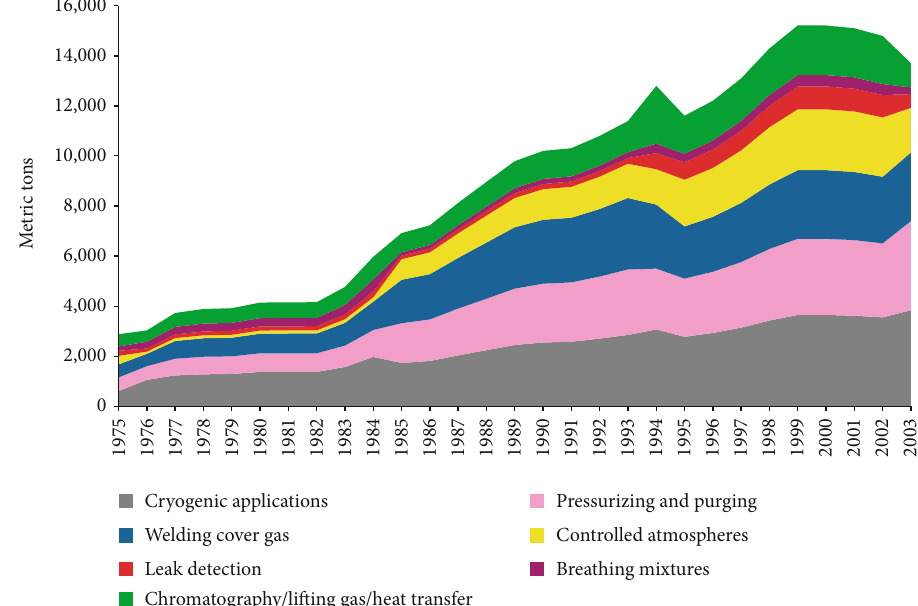
Figure 1: Application of helium (2021 Minerals Yearbook of USGS).